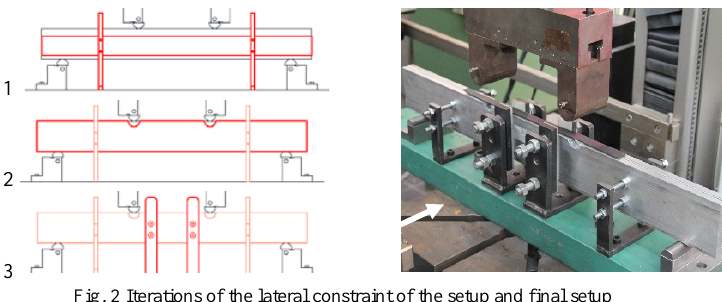
Fig. 2 Iterations of the lateral constraint of the setup and final setup